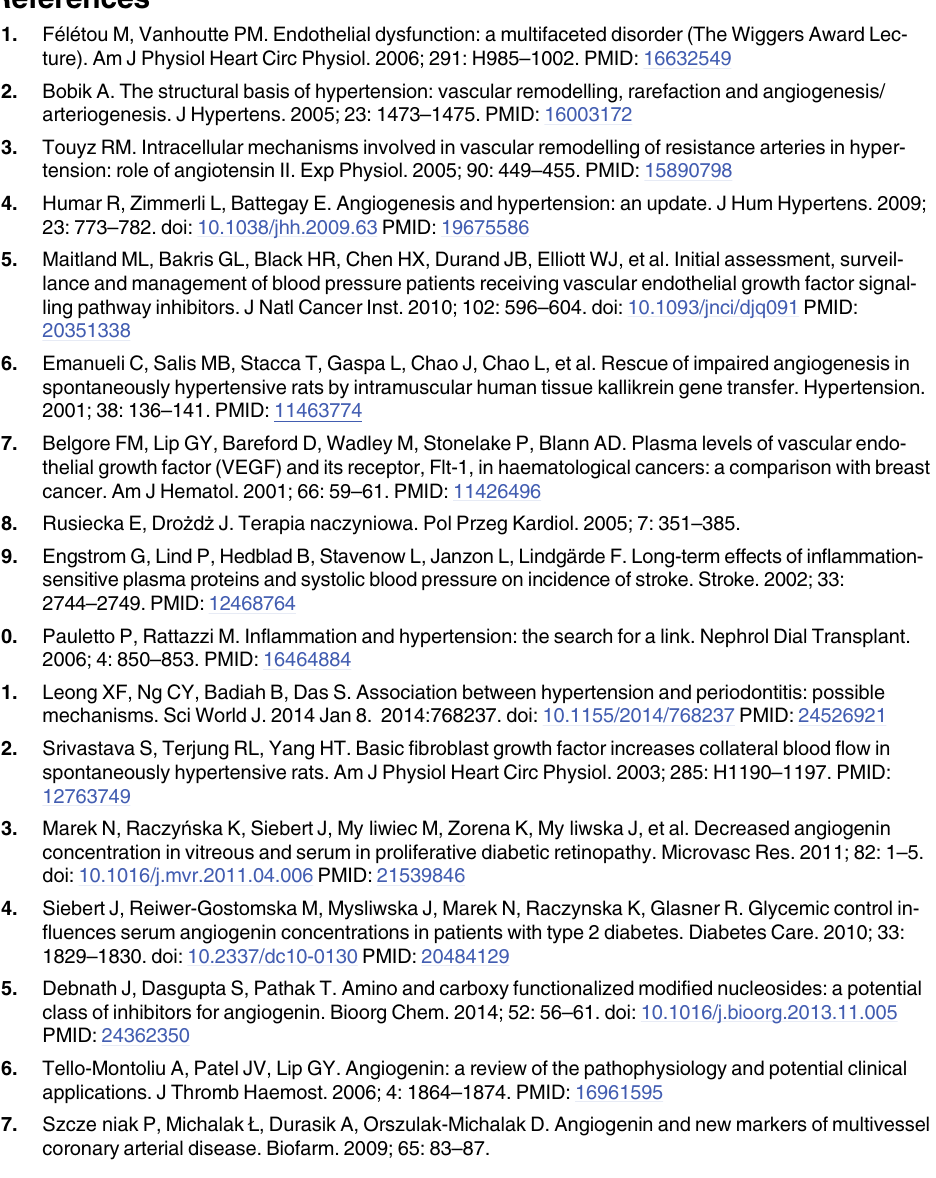
S5 Table. Assessment of the impact of age, BMI and serum lipid levels on serum endostatin concentration. Multiple regression analysis was used to assess the influence of independent predictors such as: age, BMI, triglycerides and LDL on serum levels of endostatin.